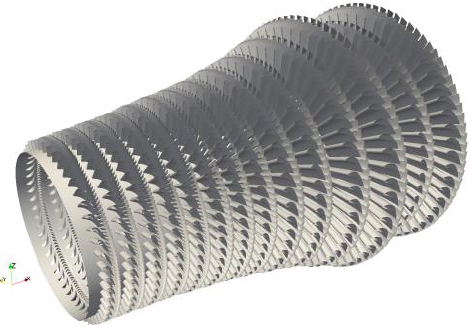
Figure 19. Static pressure contours in a blade-to-blade section at the mid blade span Figure 19: Static pressure contours in a blade-to-blade section at the mid blade span 4.3. Cogeneration medium-pressure turbine